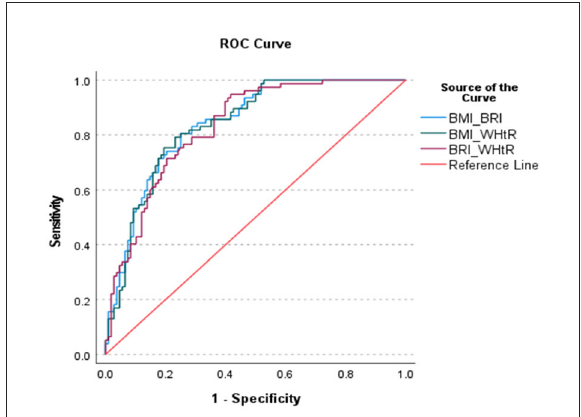
FIGURE3 ROC curve of the various combination of two anthropometric indices fir identifying the MetS.